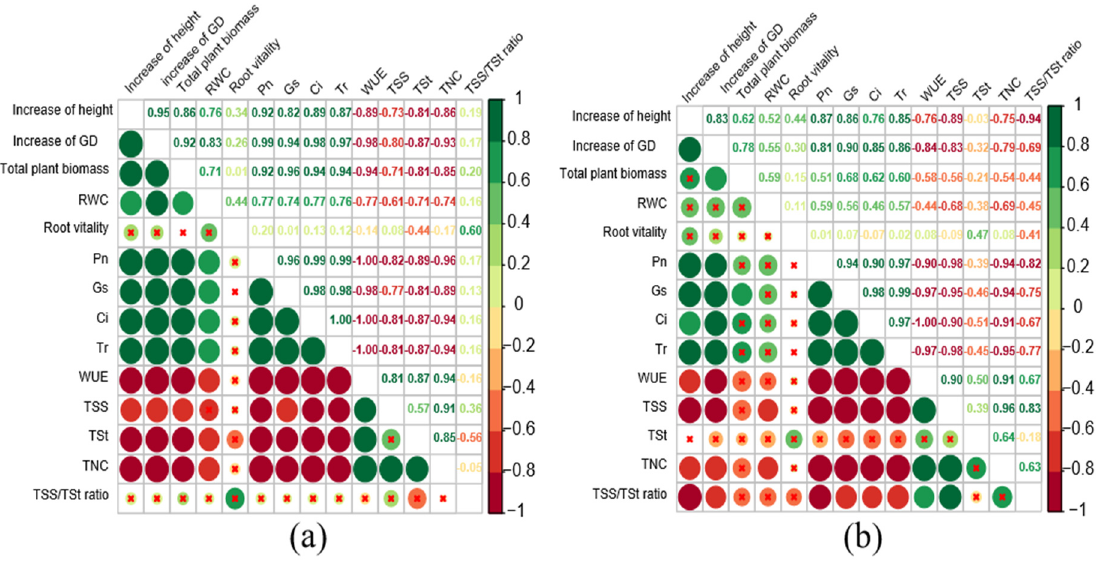
Figure 9. Pearson correlation coefficients among growth, total biomass, water status, and other physiological and biochemical indexes in NM seedlings ( a ) and M seedlings ( b ) × represents p > 0.05, with no significant correlation. TSS/TSt ratio, the ratio of whole plant soluble sugar to whole plant starch; GD, ground diameter.